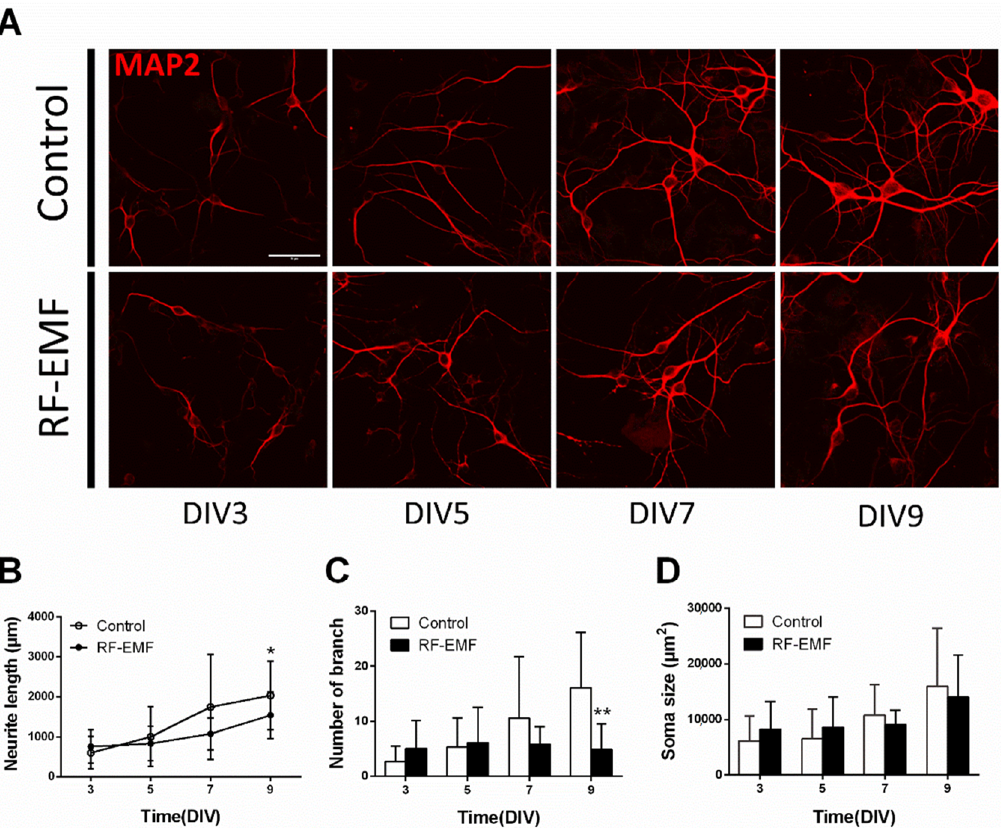
Figure 7. Exposure to RF-EMF decreased neurite outgrowth in developing hippocampal neurons. ( A ). Confocal images display neurite outgrowth (MAP2, red) in developing neurons. ( B ). Time-dependent changes in neurite length C. Number of branches D. Soma size. Data are expressed as means ± SD. Statistical significance was evaluated using ANOVA ( B ) or Student’s t -test ( C , D ). * p < 0.05, ** p < 0.01 vs. control (control n = 20 mice, RF-EMF n = 16 mice). Scale bar = 15 μm.